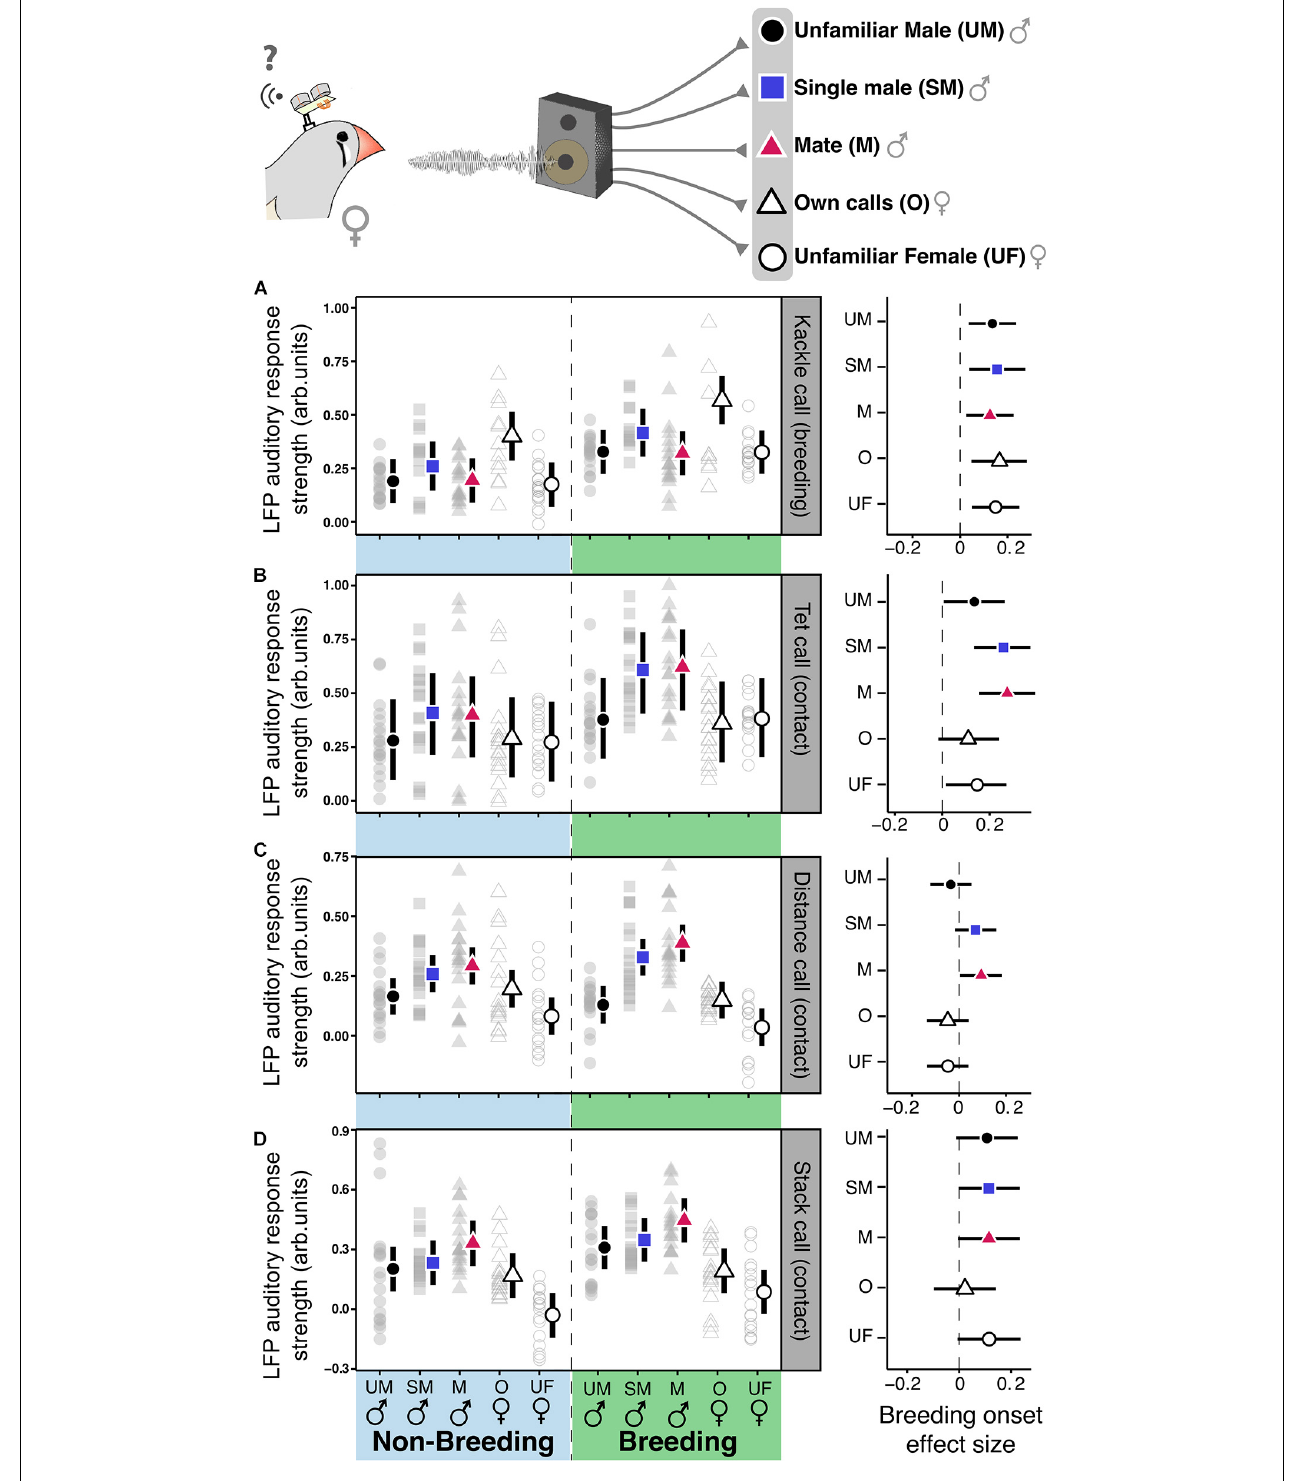
FIGURE 5 | In females contact calls-related auditory plasticity in NCM depends on the identity of the emitter. Left panels show NCM’s auditory response strength in the low-gamma band toward breeding (A) and contact calls (B–D) of different emitters [Unfamiliar male [UM], Familiar Single Male (SM), Mate (M), Own calls (O), Unfamiliar Female (UF)] in non-breeding (NB) and breeding (B) contexts. Colored shapes represent the estimates, vertical bars the 95% CrI from the linear mixed models and gray shapes the raw data. The right panel of each segment (A–D) shows the model estimate and 95% CrI of the breeding induced effect size of the stimuli from different emitters within each call type. An statistically meaningful effect can be assumed if the effect sizes’ CrI do not overlap cero.